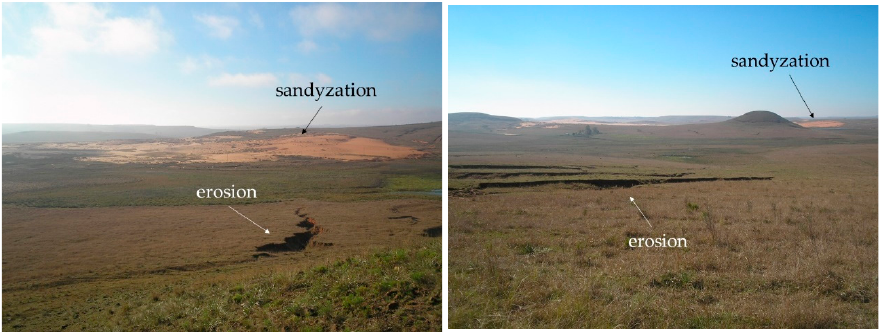
Figure 4. Pictures showing the native field. Soil exposing the sandyzation and erosion in the Quartz- ipsamments of the Southwest of Rio Grande do Sul State, southern Brazil. Source: pictures taken by L.E.A.S. Suzuki.